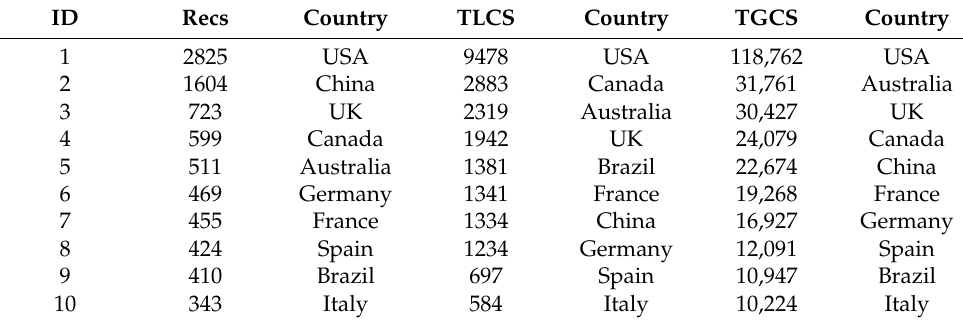
Table 3. Top ten influential countries in terms of Recs, TLCS, and TGCS.